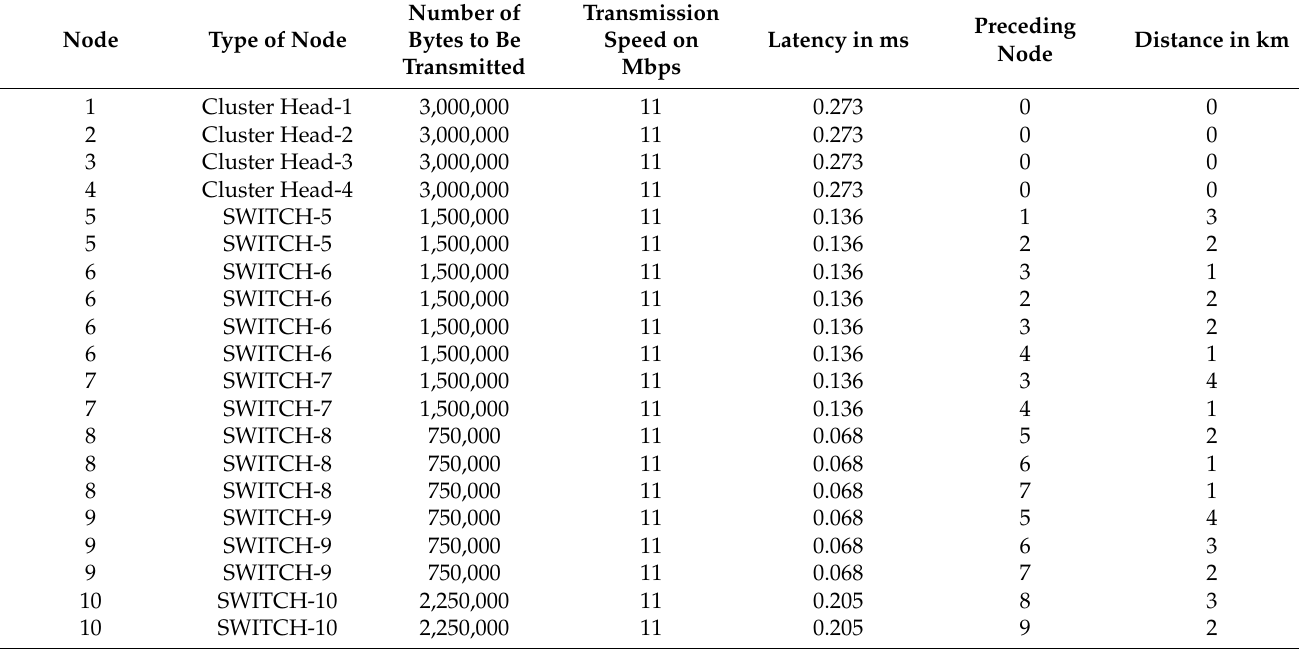
Table 1. Precedence Matrix for the Example Network